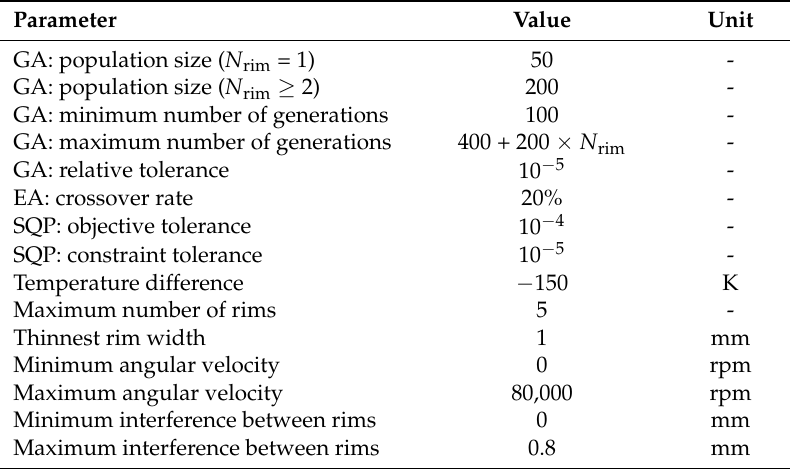
Table 8. Algorithm parameters for the case